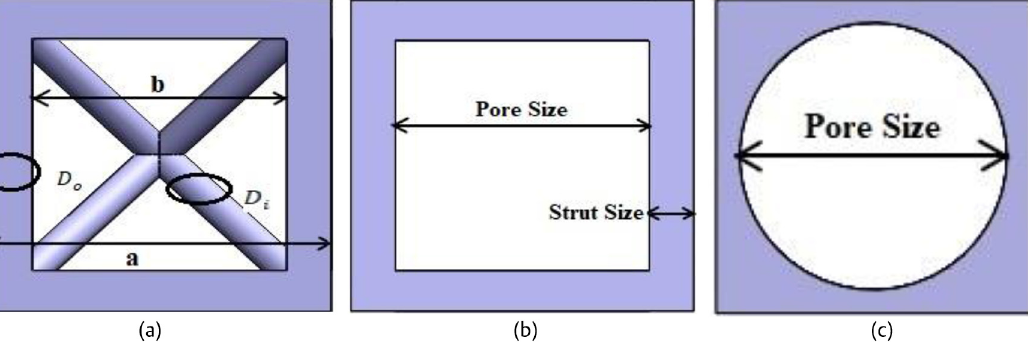
Fig. 1. The geometry of the unit cell of the porous structures; (a) BCC unit cell, (b) Cubic unit cell, (c) Spherical unit